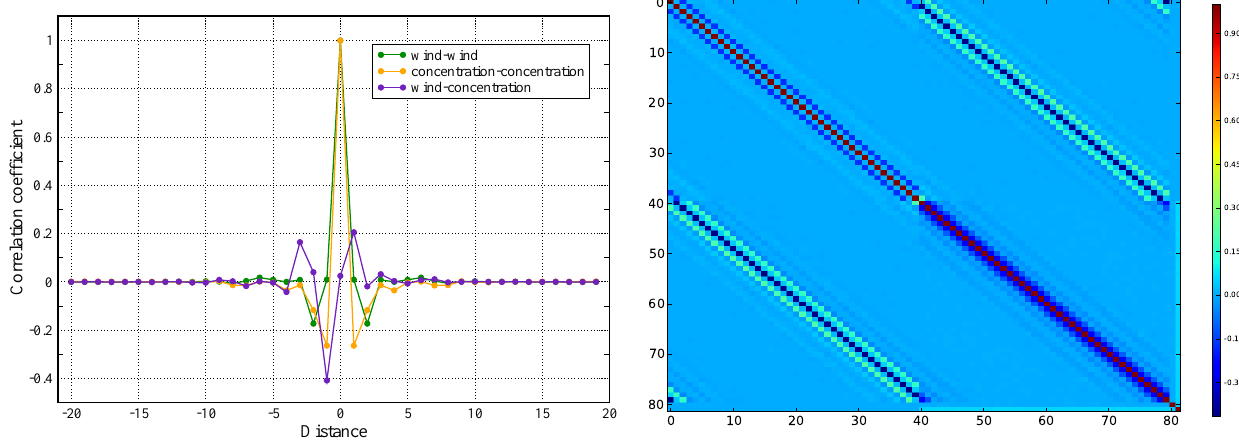
Fig. 13. Structure functions of the correlation of the errors of the initial condition from the IEnKS applied to the online tracer model. The structure functions for the wind correlation, for the concentration correlation, and for the cross-correlation between winds and concentrations are shown in the left panel. The full correlation matrix is displayed in the right panel.